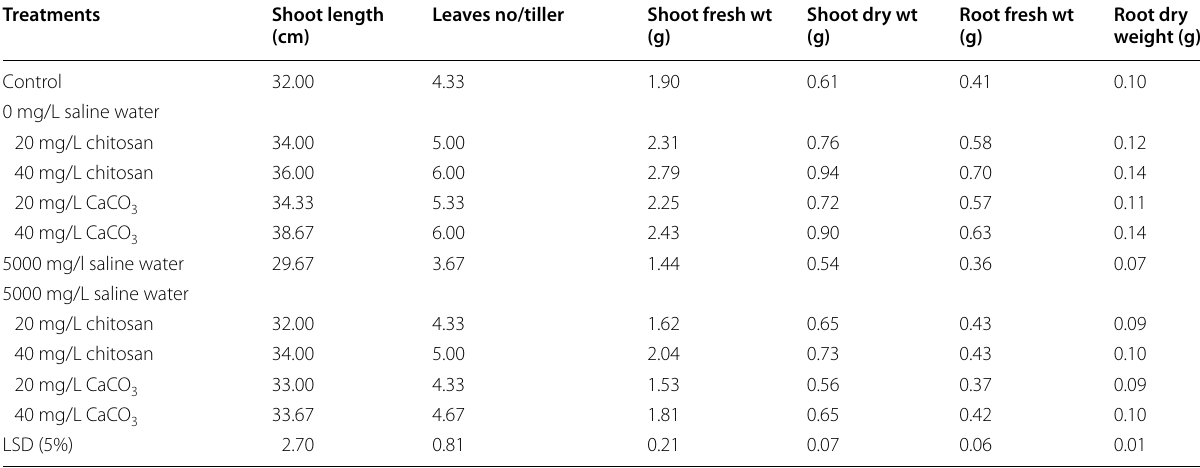
Data are means of two seasons